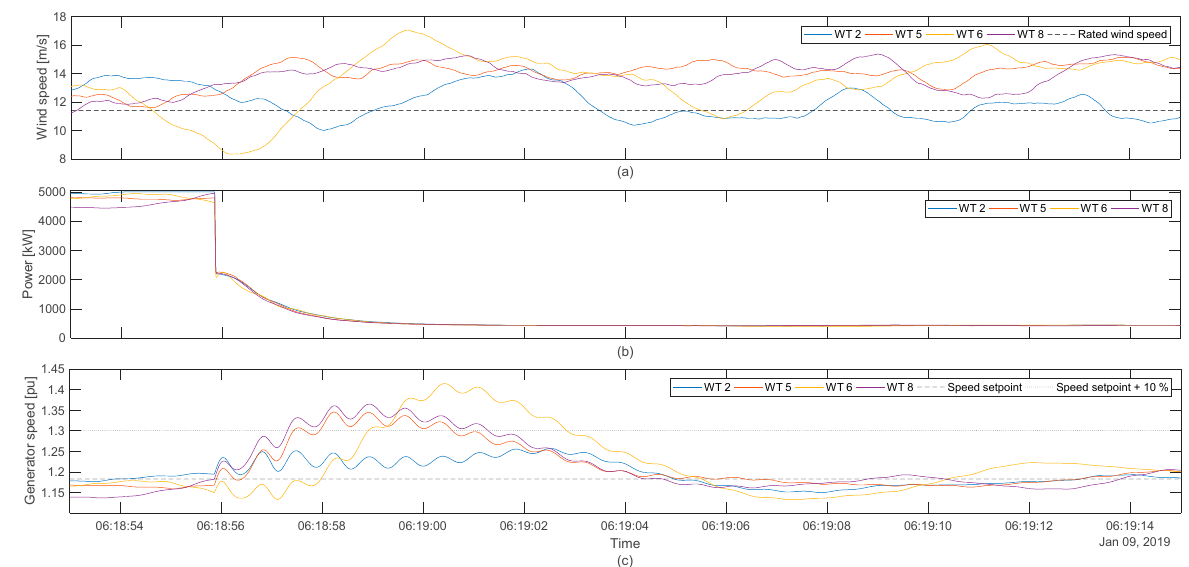
Energies 2021 , 14 , x FOR PEER REVIEW Figure 13. Simulation results of scenario II for 4four WTs: ( a ) Wind speed and rated wind speed; ( b ) Generator power; ( c ) generator speed, speed setpoint, and overspeed threshold. The time axis of ( c ) is valid for the above subplots as well.